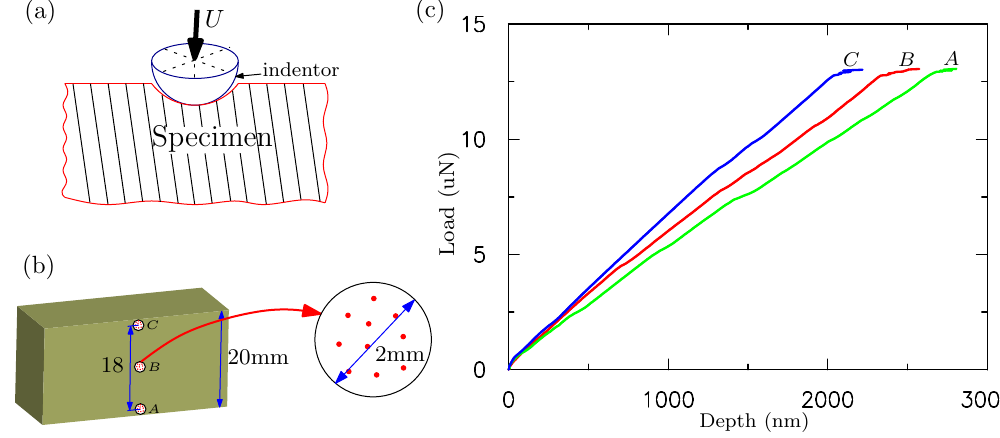
Figure 6. ( a ) schematic of nanoindention test; ( b ) measured load vs. ( c ) indentation depth at the different locations on the cuboid silicone rubber along height direction. Different locations are marked as ‘A’, ‘B’, and ‘C’ on the specimen shown in the